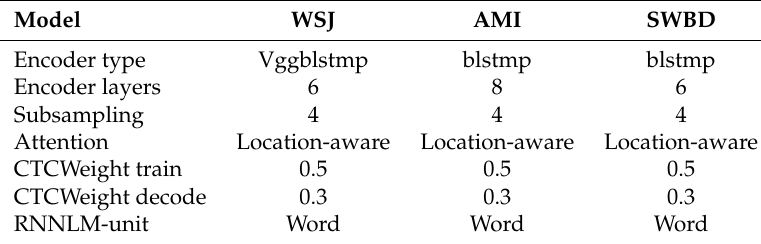
Table 1. Experimental